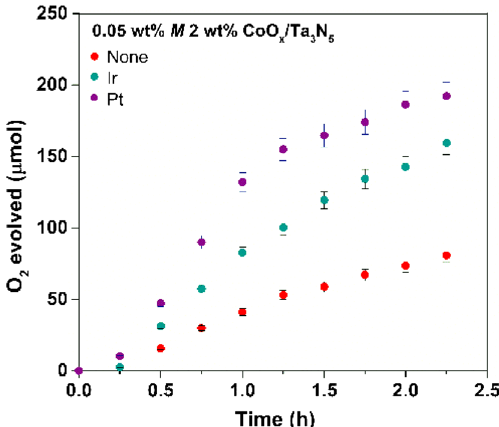
Fig. 10 Time course of photocatalytic OER on CoO x /Ta 3 N 5 . (0.1 M